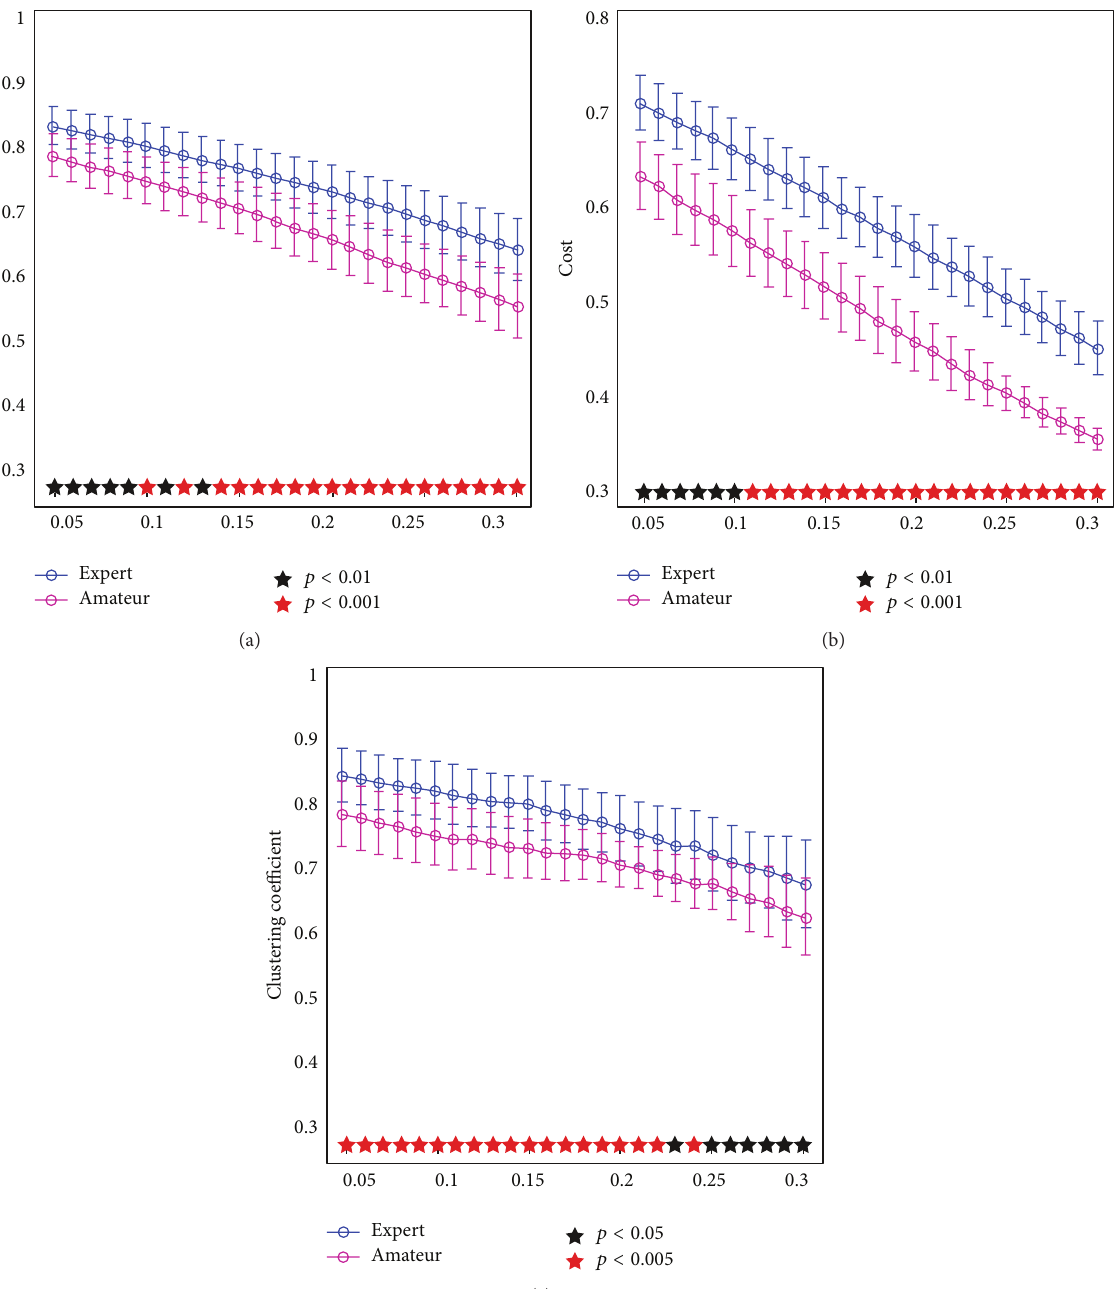
characteristics, and FC both within and between networks compared to amateurs. Thus, AVG experience may be related to enhanced integration between SN and